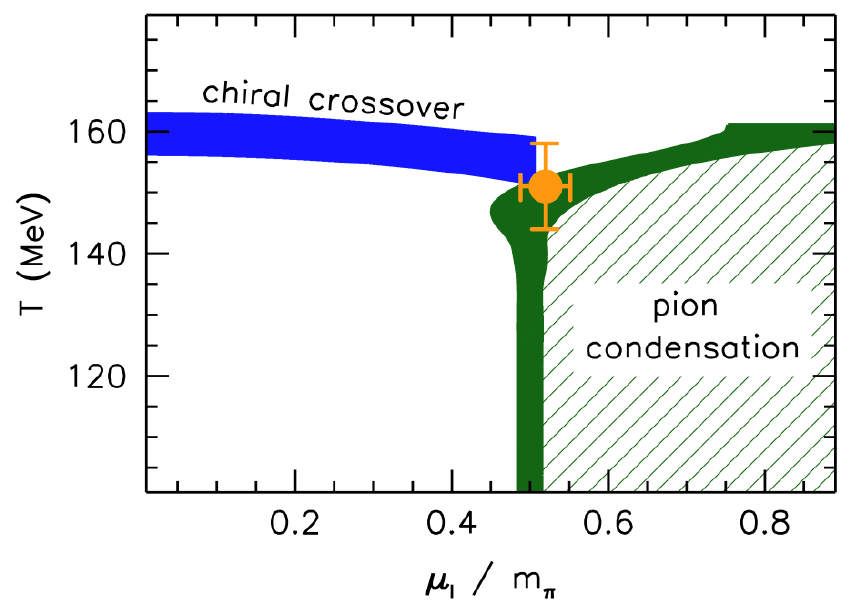
Figure 8. Lattice results for the phase diagram of QCD in the temperature-chemical potential for isospin plane, from Ref.